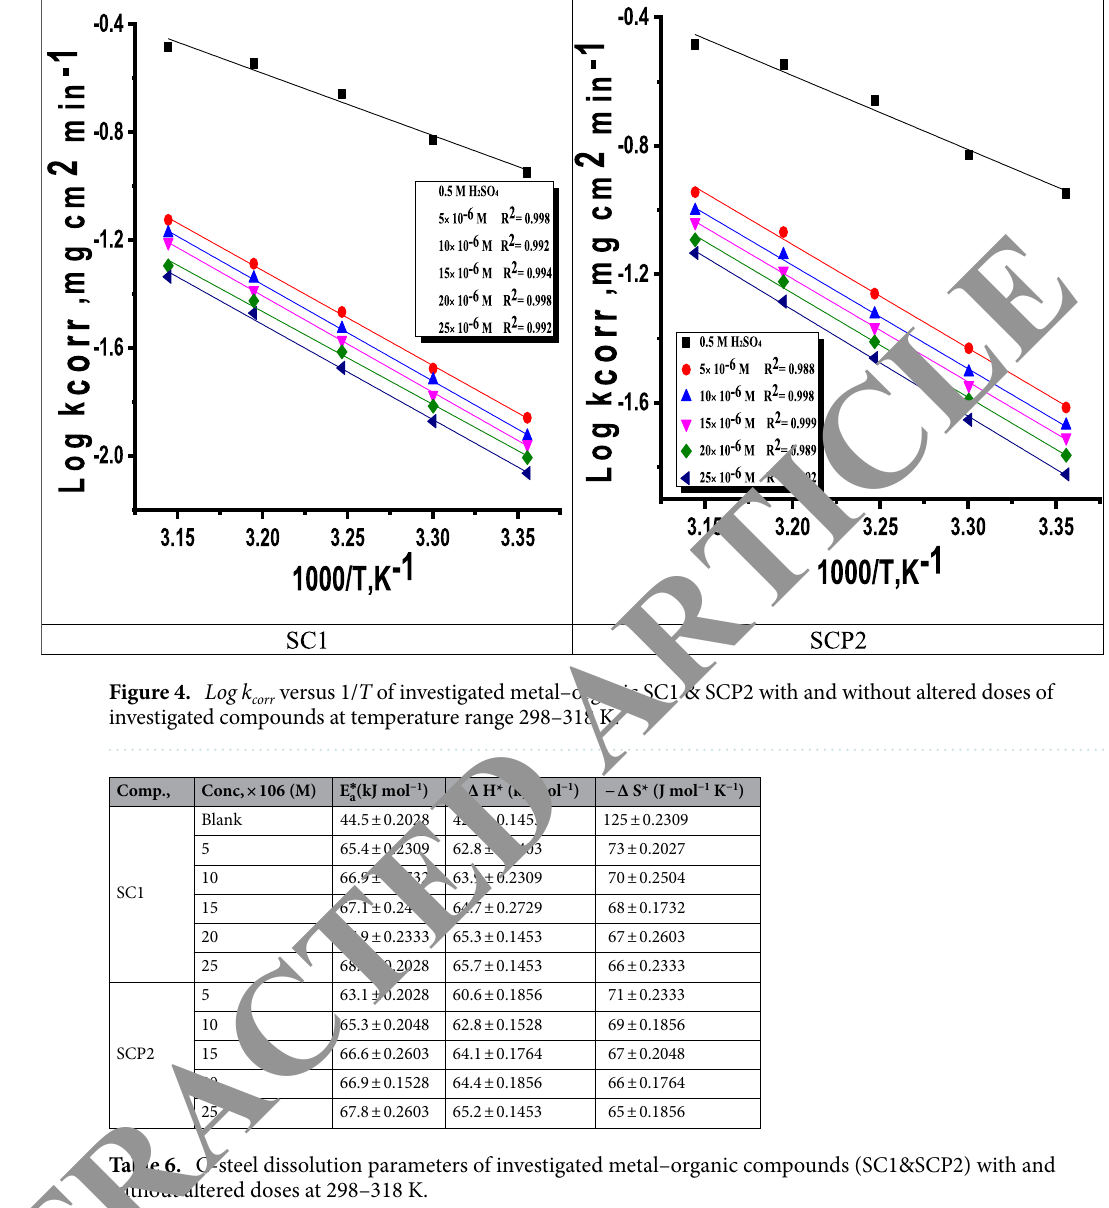
Table 6. C-steel dissolution parameters of investigated metal–organic compounds (SC1&SCP2) with and without altered doses at 298–318 K.